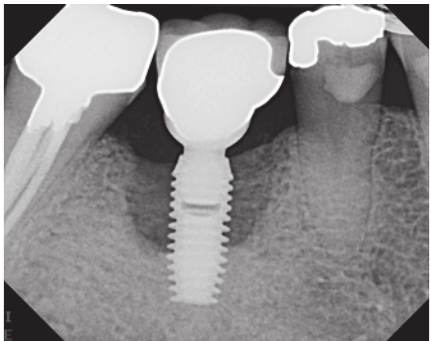
Figure 22: Four years following treatment. The site continued to present with inflammation and deep peri-implant probing depths.